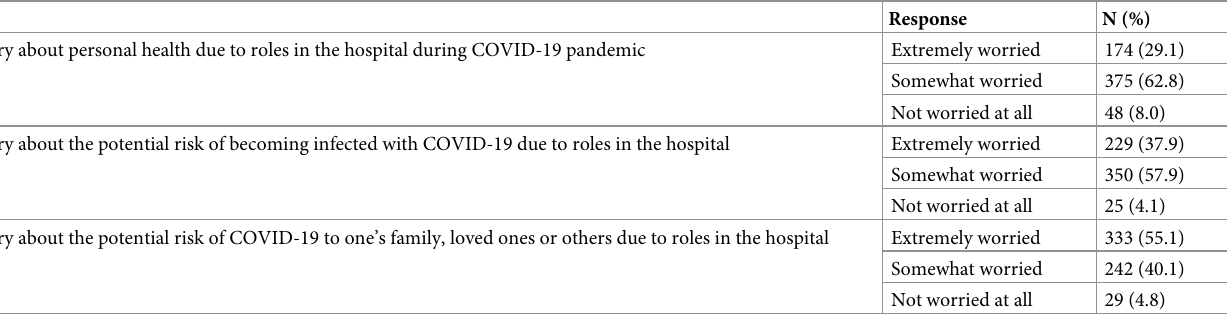
Table 3. Healthcare providers perceived worries about COVID-19